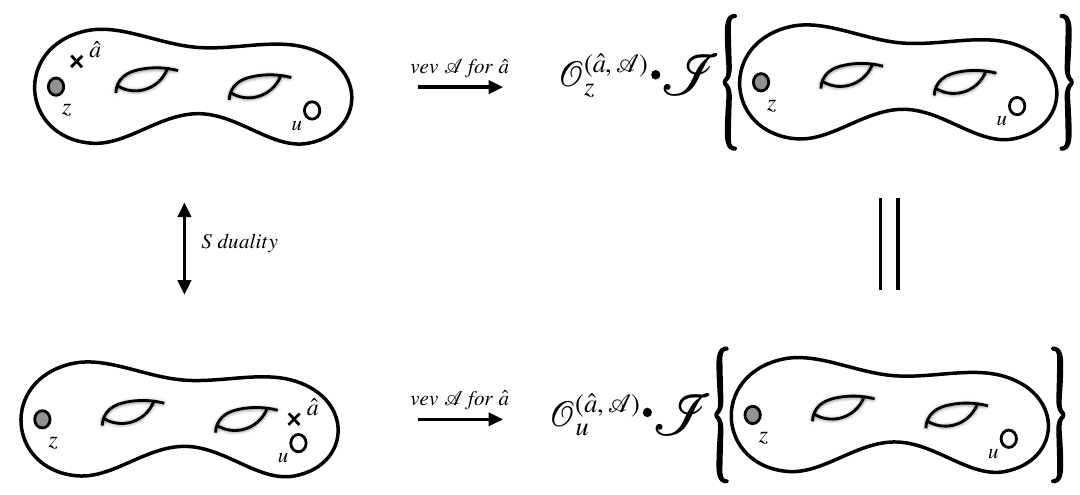
Figure 3: Here we give vev to an operator labeled by A charged under minimal puncture symmetry ˆ a . We consider two duality frames. In each frame the minimal puncture is close to a different maximal puncture, labeled by z and u . The fact that the duality frame does not matter for the computation, as the index is independent of the value of the continuous couplings, the two computations give the same result. This implies that the index of the theory without defect generated by the vev, regarded as the function of maximal puncture parameters z and u , is a Kernel function for the difference operators introducing the